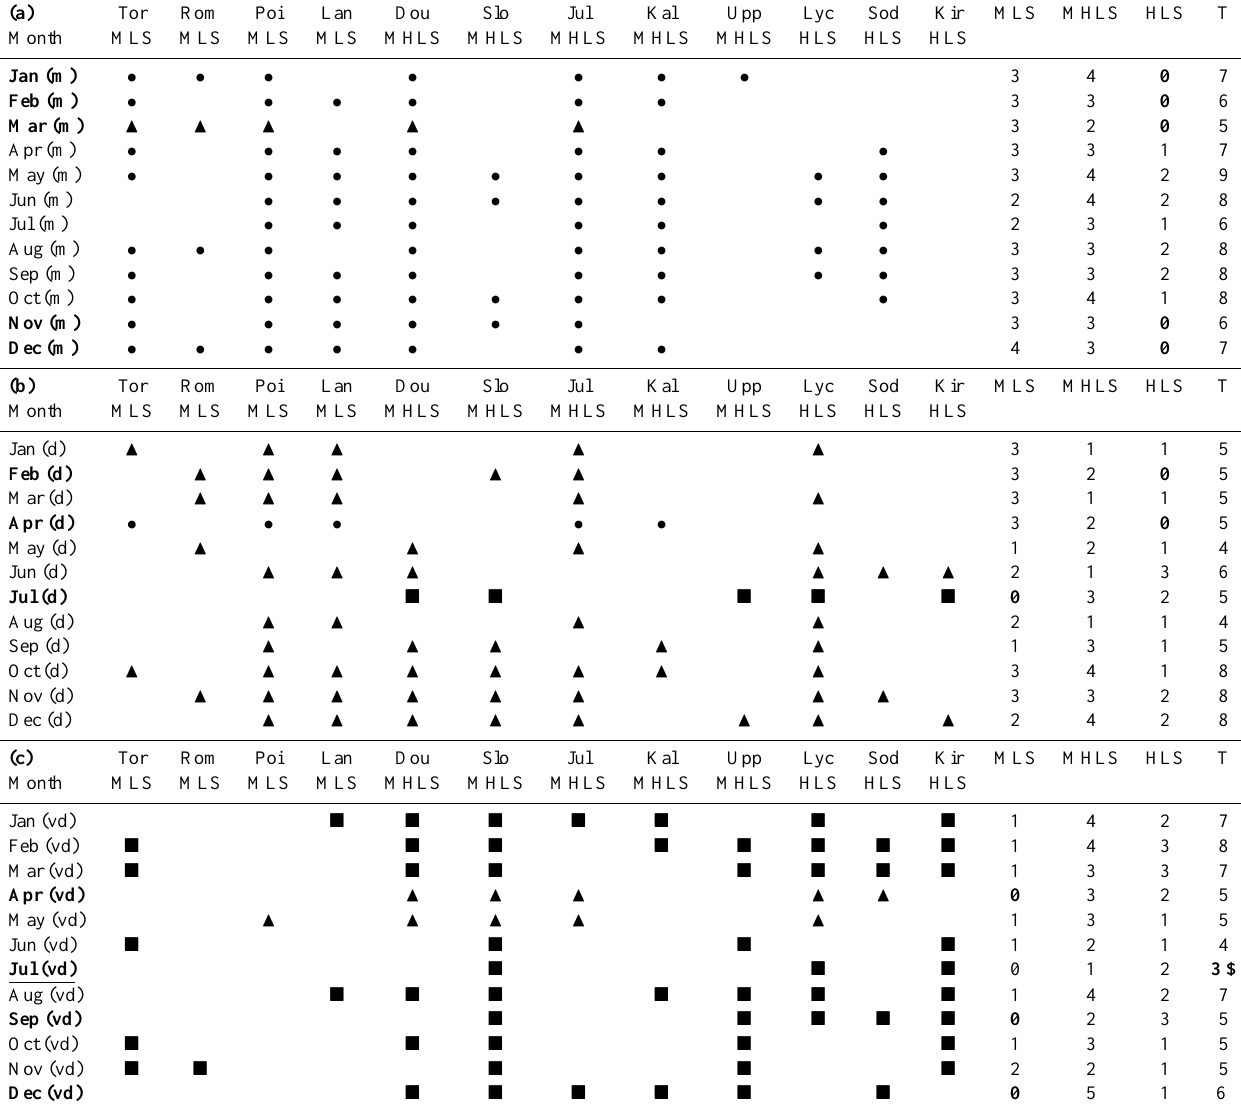
Table 7. Same as Table 6, but with some improvements for a possible operative